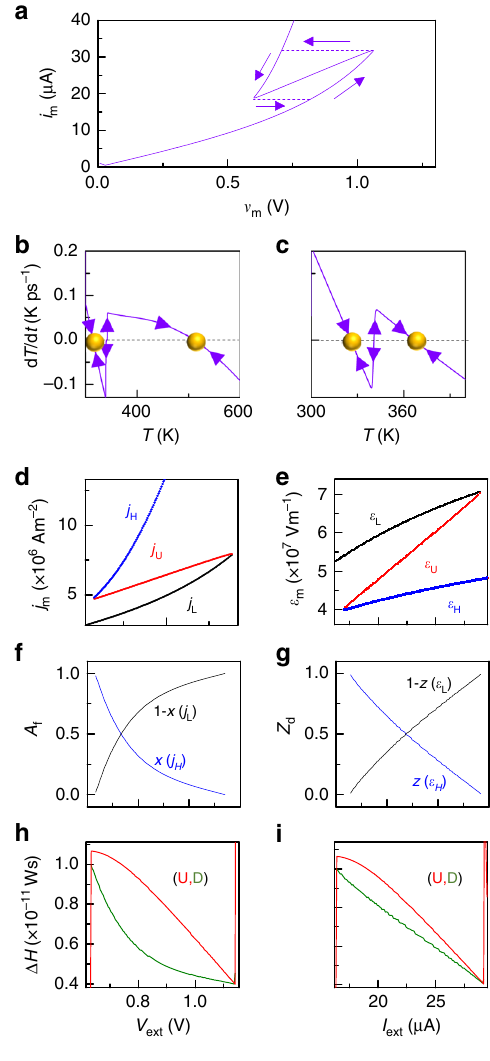
Fig. 3 Temperature-controlled instability due to a Mott transition. a i m – v m plots from Eqs. (1) and (2) with the Mott transition at 340 K parameterized within R th , representing VO 2 . Solid line: parametric T-sweep. Dashed line: T /d t vs. T for an applied external voltage of 0.7 V. c d T /d t vs. i m -sweep. b d T for an applied external current of 25 µ A. Yellow spheres indicate stable steady-states. d Stable ( j H and j L ) and unstable ( j U ) current densities corresponding to the steady-states for different applied V ext . e Stable ( ε H and ε L ) and unstable ( ε U ) electric- fi elds corresponding to the steady-states for different applied external current I ext . f Area fractions ( A f ) of the two decomposed current-density states ( x and 1 − x ) plotted against V ext . g Thickness fractions ( Z d ) containing the two decomposed states ( z and 1 − z ) plotted against I Δ H vs. V ‘ U ’ ) and decomposed ext . h ext for the unstable ( ( ‘ D ’ ) current-density states. i Δ H vs. I ext for the unstable and decomposed electric- fi eld